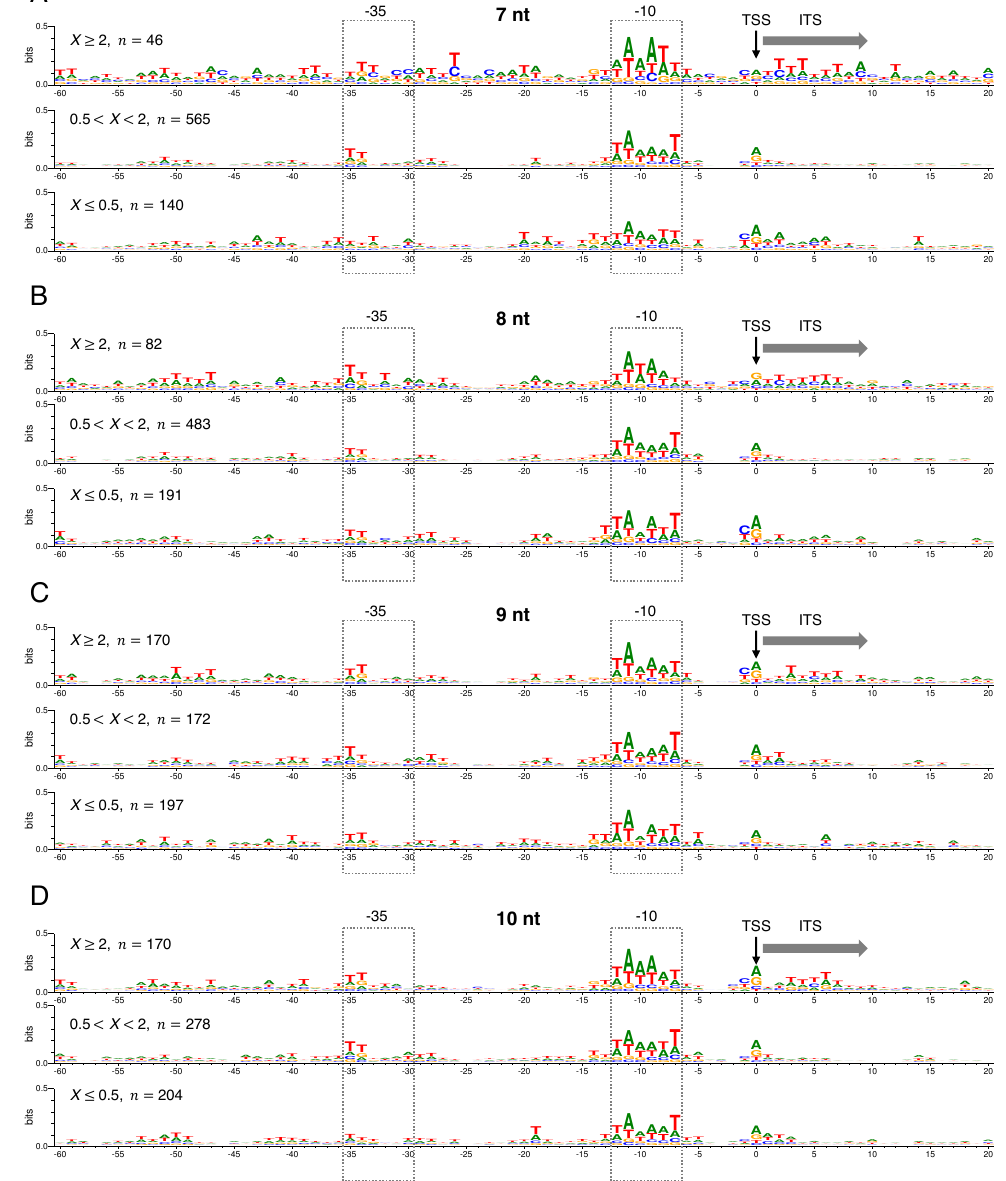
Figure 3. The e ff ect of consensus mode of holoenzyme-DNA binding on initiation complexes having nascent RNAs of 7 nt ( A ), 8 nt ( B ), 9 nt ( C ), and 10 nt ( D ), respectively. The consensus e ff ect is classified into the three promoter groups where abortive synthesis or pausing was decreased ( X ≥ 2) (top), una ff ected (0.5 < X < 2) (middle) and increased ( X ≤ 0.5) (bottom) by Gre proteins. Here X represents nrt ( ∆ greAB ) / nrt (WT) ratio for the RNET-seq reads of each length that is mapped to the close vicinity of TSS of σ 70 promoters; n represents the number of promoters composing the group. We have excluded rRNA promoters and promoters for unexpressed genes from these 775 σ 70 promoters. The sequence conservation (information content, bits) in the promoter DNA region (from − 60 to + 20, where TSS is + 1) is represented by Sequence Logo [34]. − 10 and − 35 motifs are shown by boxes. TSS and ITS are shown by a vertical arrow and by a lateral arrow,